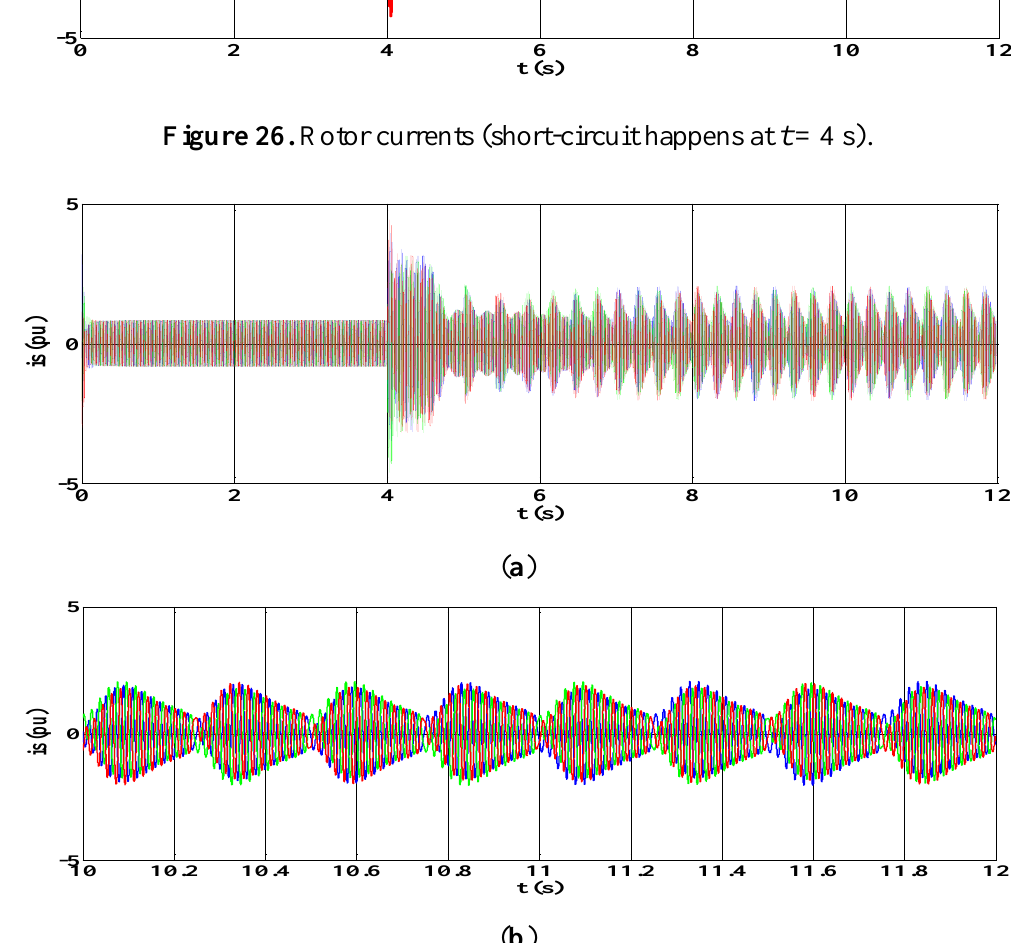
Figure 27. ( a ) Stator currents (short-circuit happens at t = 4 s), ( b ) zoom of